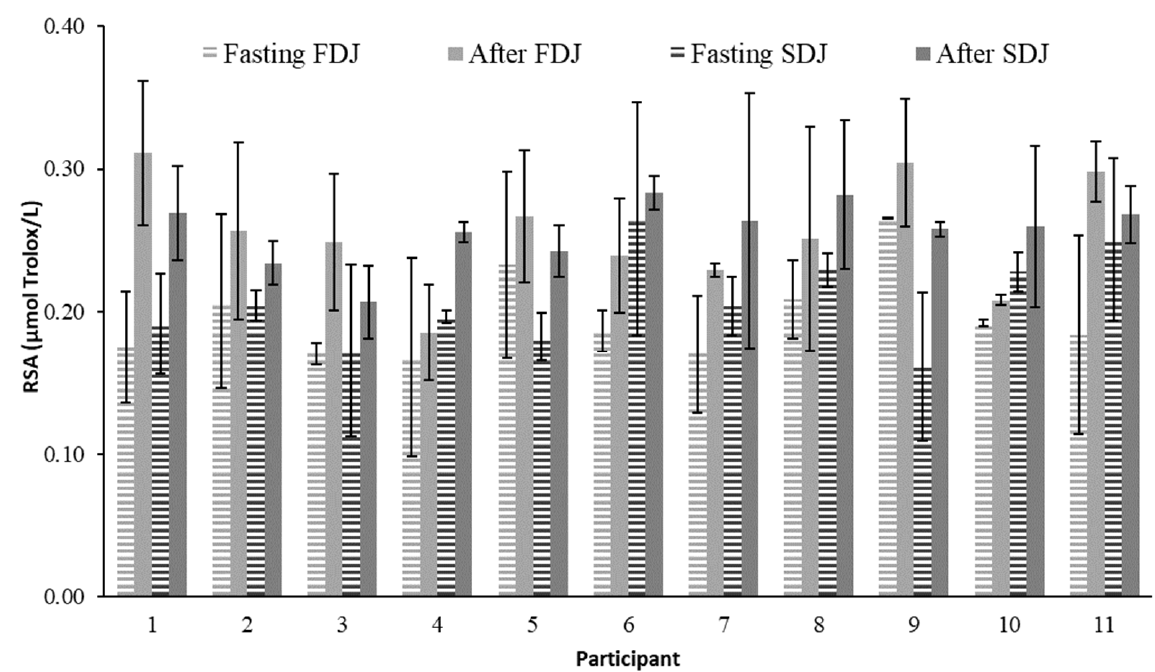
Figure 5. Mean value and standard deviation of serum blood radical scavenging ability (RSA) analyzed in the participants on the days of consuming reconstituted freeze-dried (FDJ) and spray-dried (SDJ) juices, both fasting and 4 h after the intake of each juice. To explain the relationships in the relative increases of the bioactive compounds quantified in blood serum with the RSA, Pearson correlation analyses were performed. Only VC showed a positive significant correlation with RSA (r = 0.5099, p < 0.1),